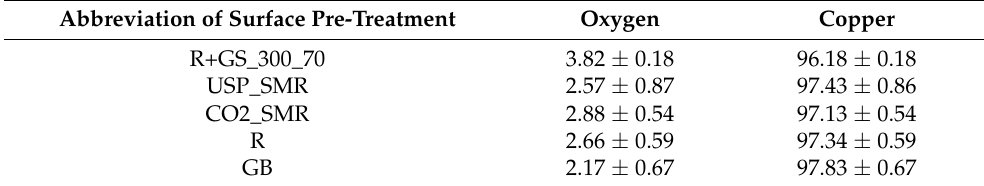
Table 5. Chemical composition in wt. % of wire arc sprayed coatings on laser-structured CFRP. Abbreviation of Surface